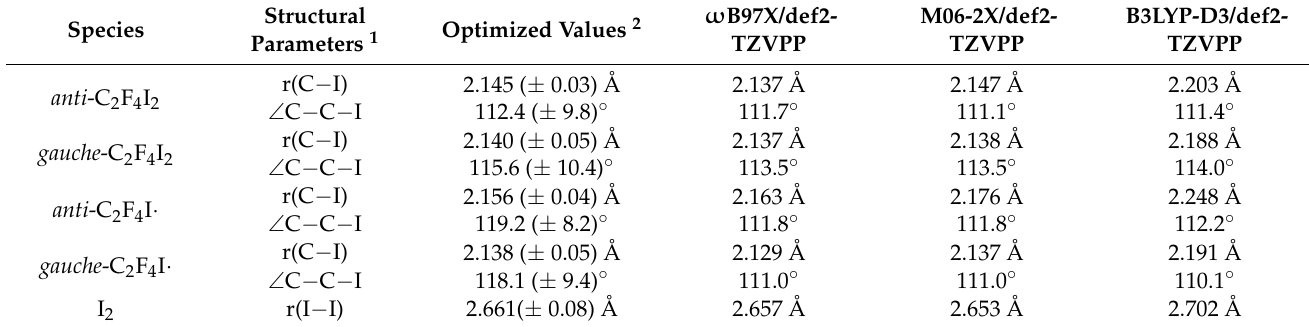
1 Parameters refer to the structural parameters of each chemical species. Parameters consisting of two atomic symbols represent bond lengths, and parameters consisting of three atomic symbols represent bond angles. 2 Errors for global-fitting parameters shown in parentheses. Other parameters not shown here are fixed at obtained values from the DFT calculations ( ω B97X/def2-TZVPP) shown in Table S2.